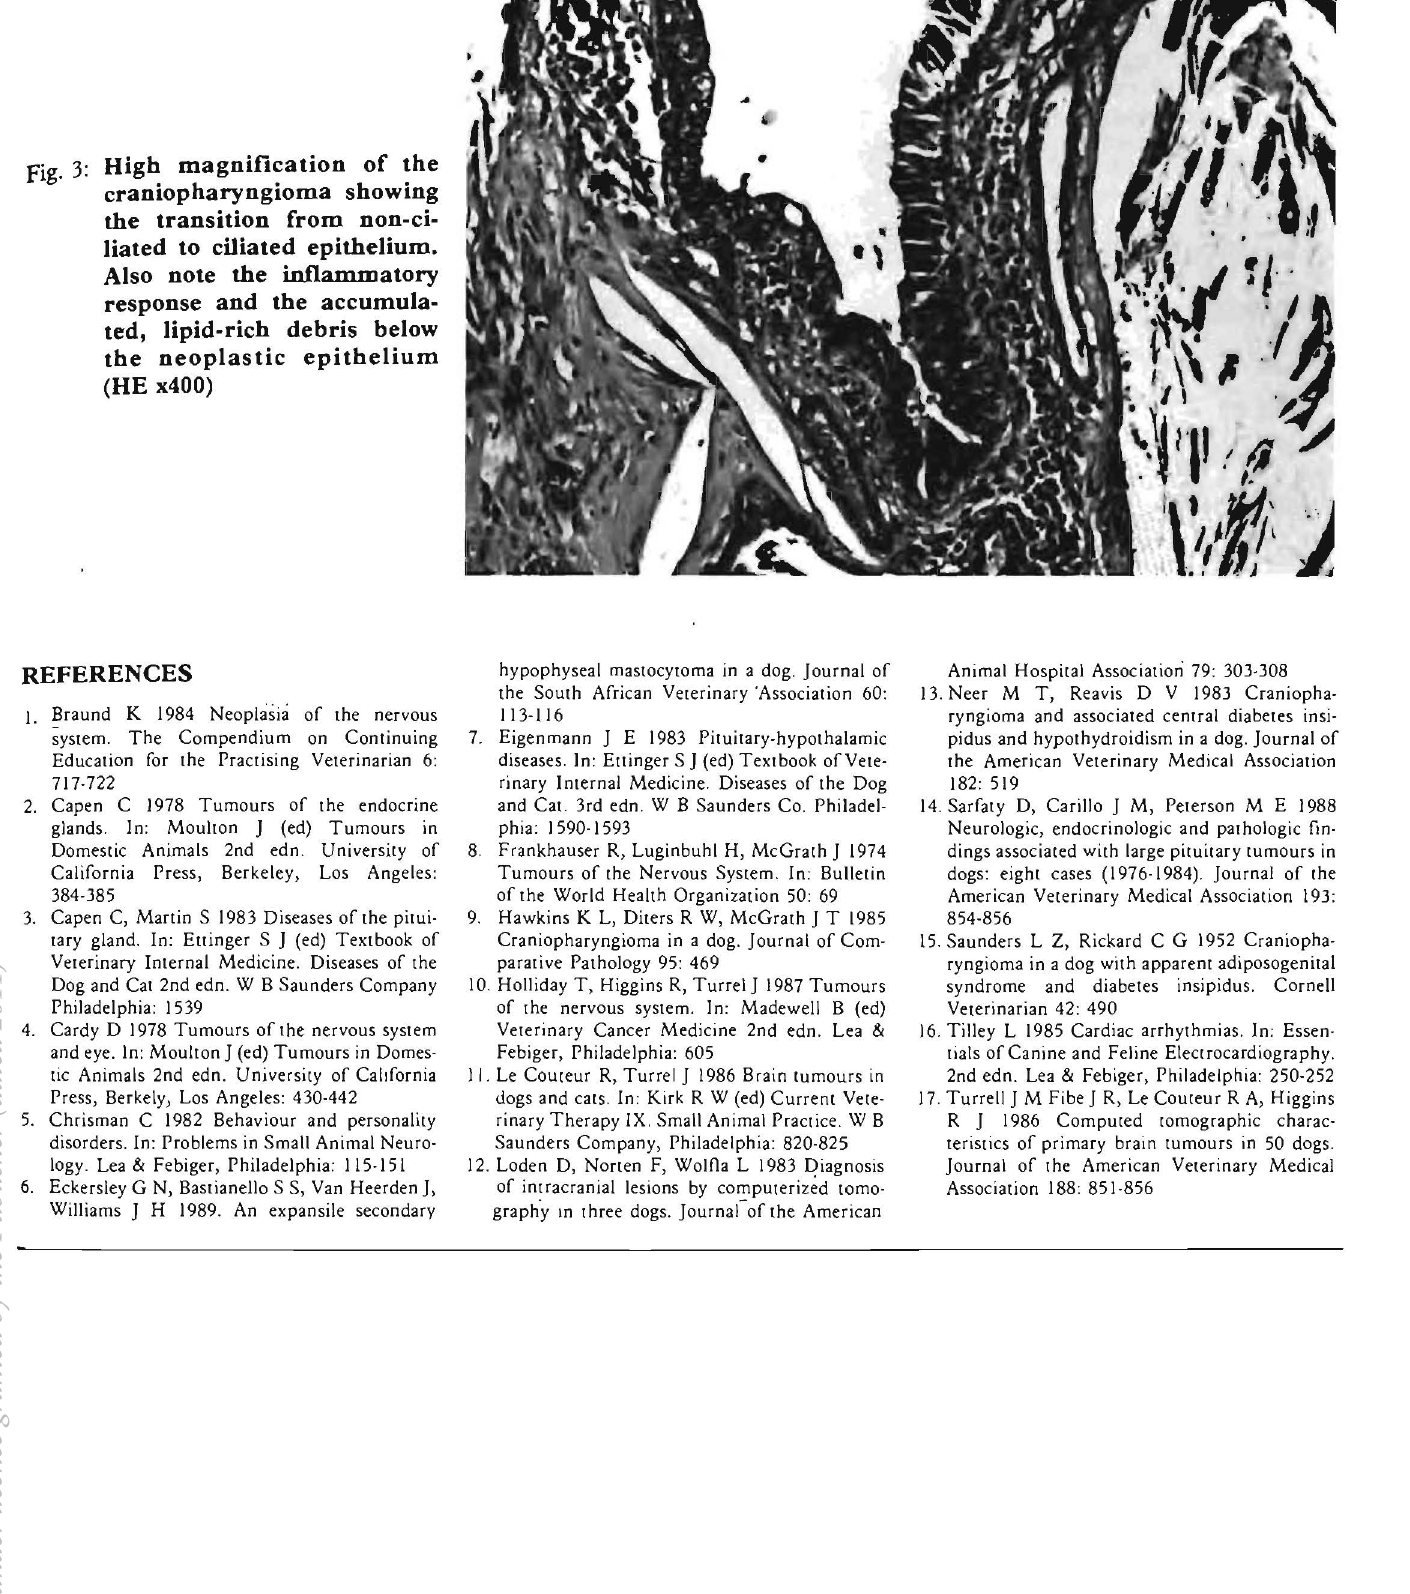
Fig. 3: High magnification of the craniopharyngioma showing the transition from non-ci liated to ciliated epithelium. Also note the inflammatory response and the accumula ted, lipid-rich debris below the neoplastic epithelium (HE